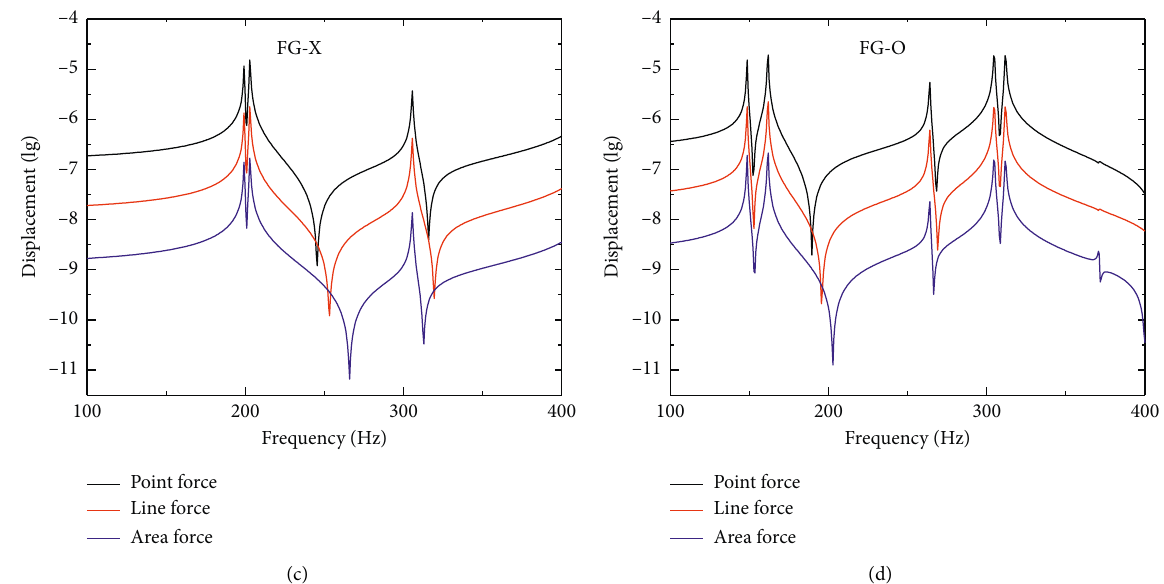
Figure 13: The frequency-displacement characteristics of multi-stepped FG-CNTRC plate under three types of